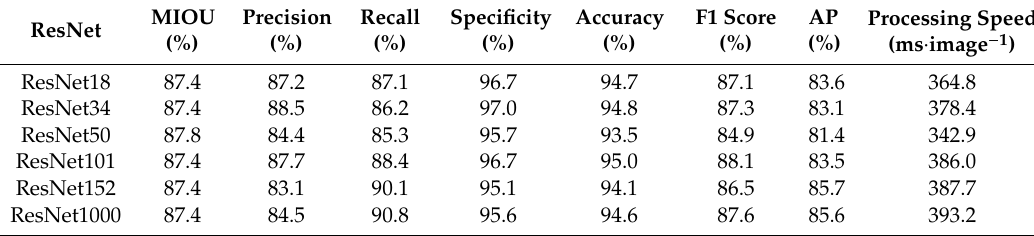
Table 3. Performance of various residual networks on preening detection.